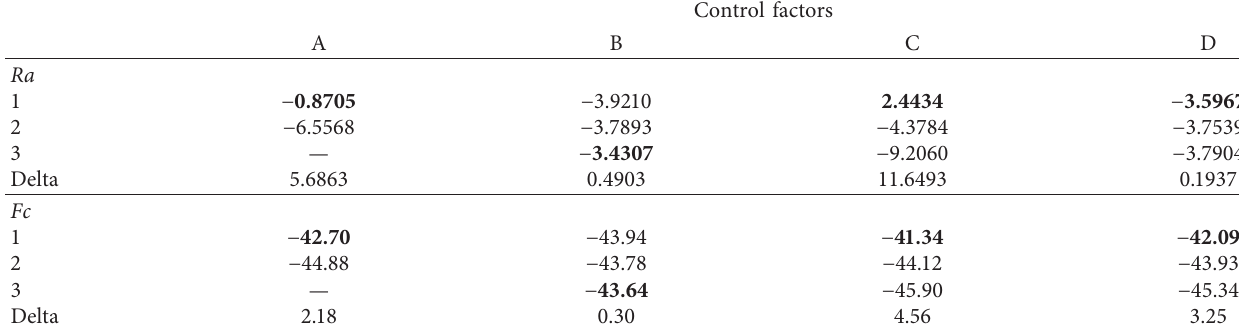
Table 5: S/N response table for Ra and Fc.